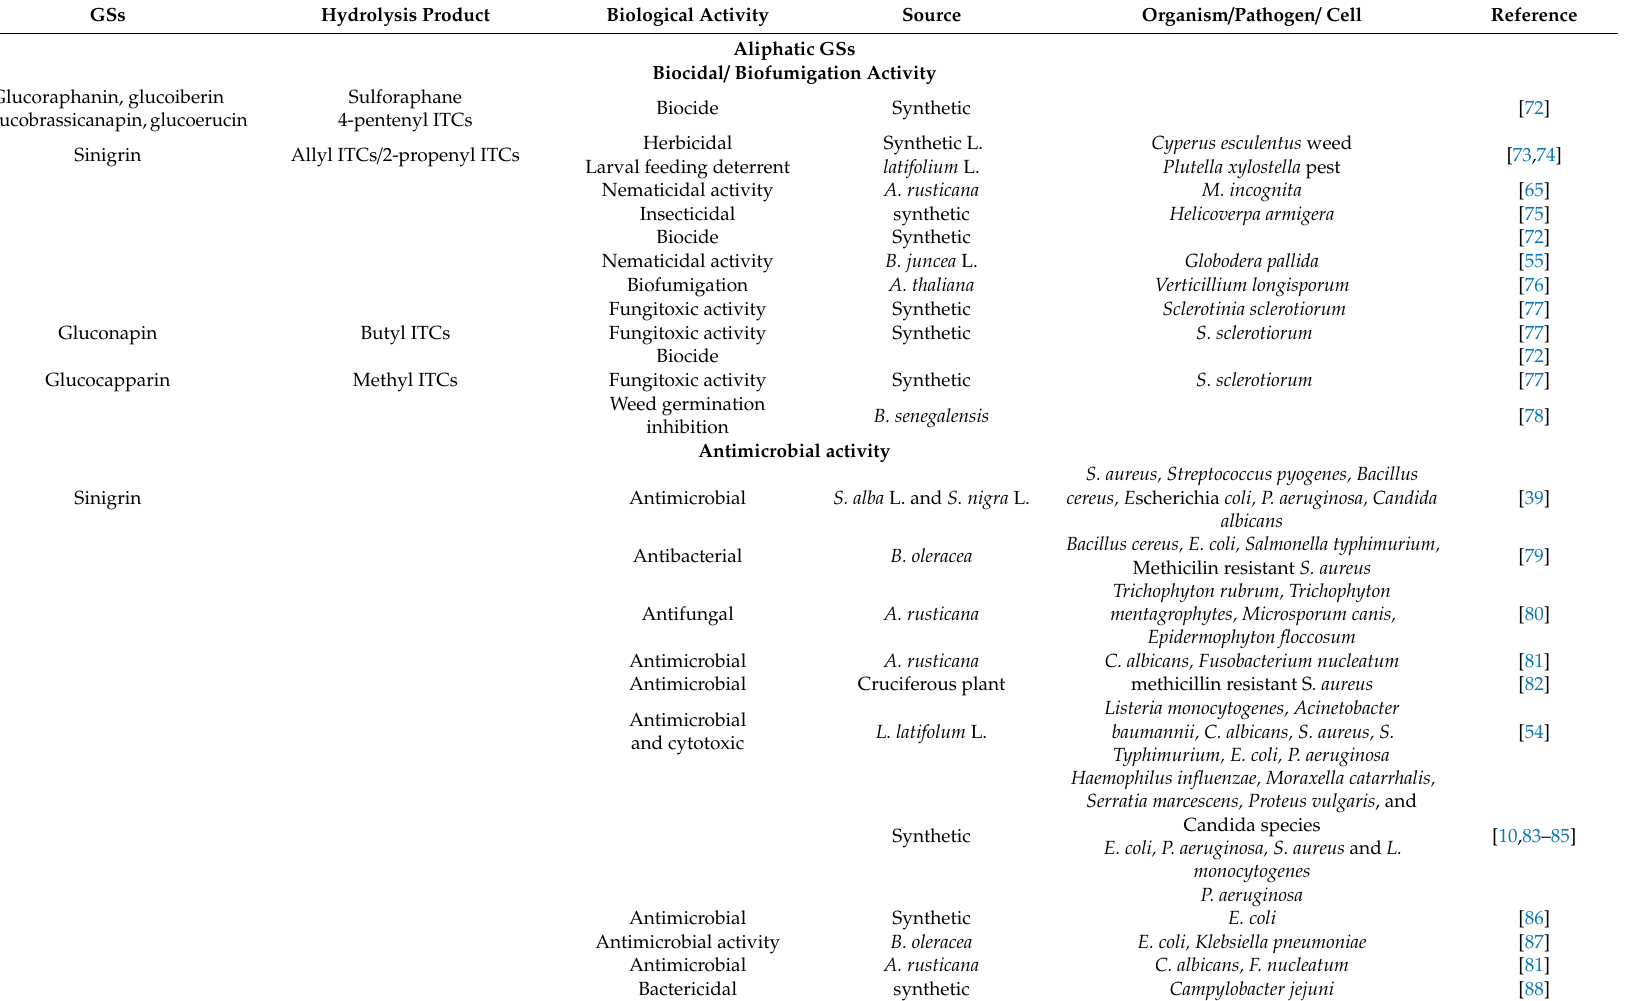
Table 1. Various health benefits of GSs and